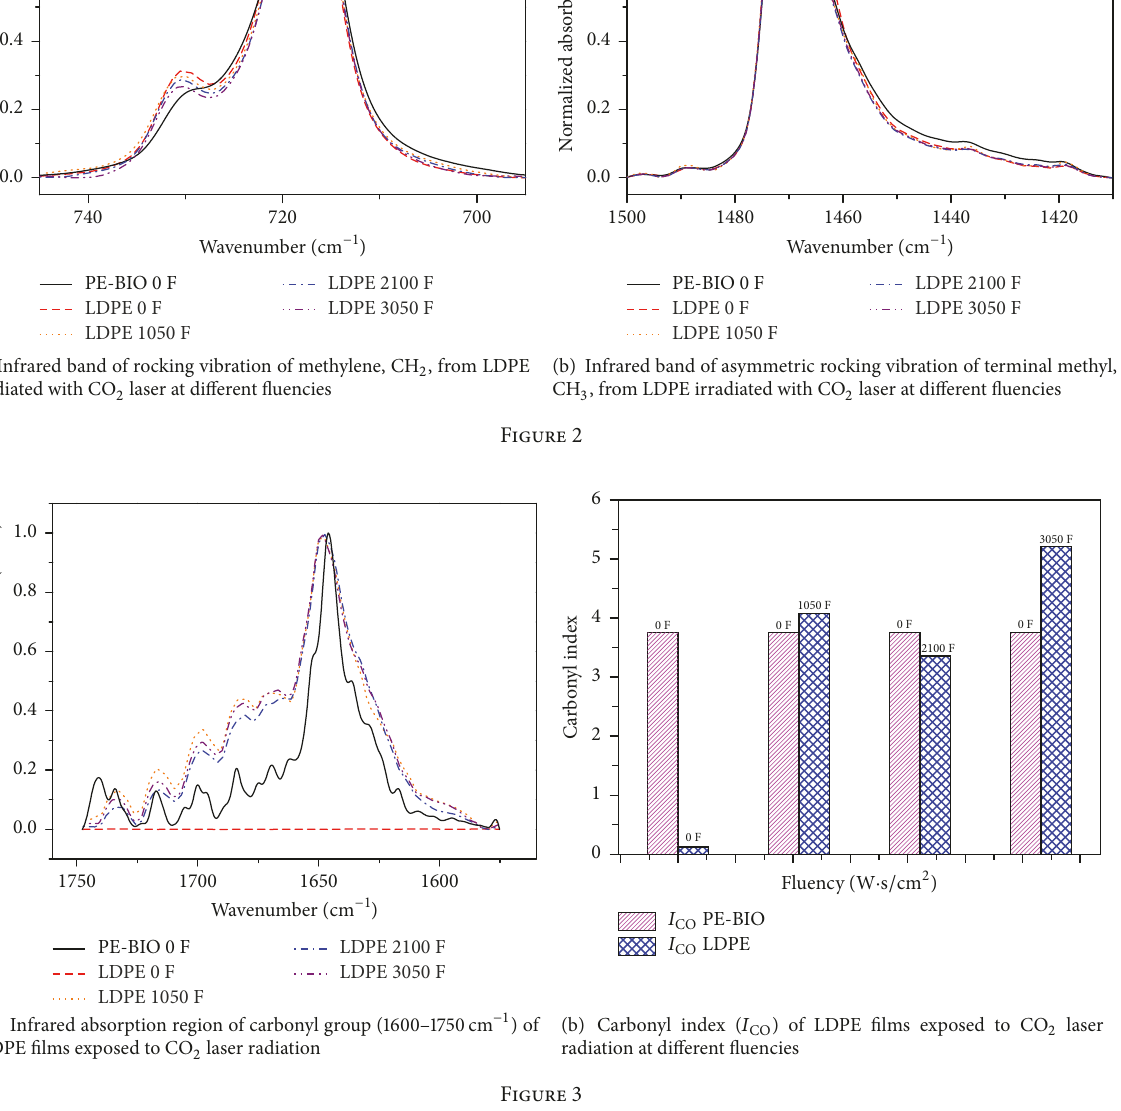
(b) Carbonyl index ( 𝐼 CO ) of LDPE films exposed to CO 2 laser radiation at different fluencies